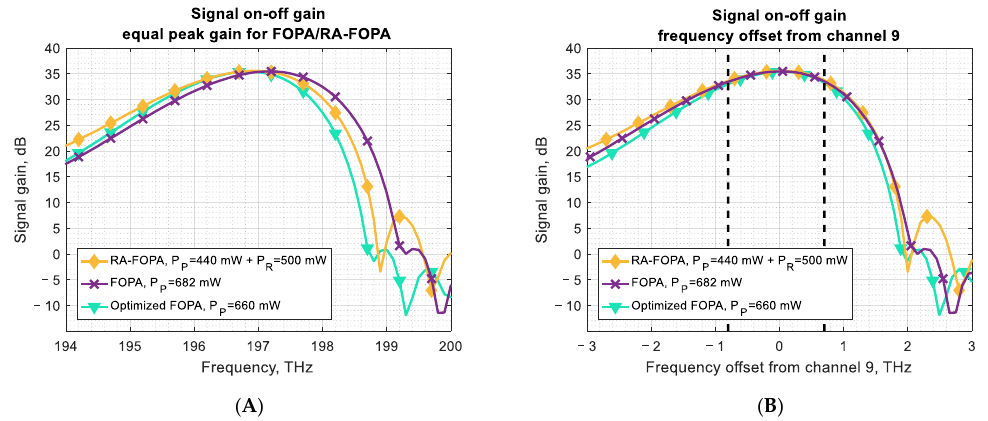
Figure 3. Fiber optical parametric amplifiers (FOPA) (violet line, crosses), optimized FOPA (cyan line, triangles) and RA- FOPA (yellow line, diamonds) signal on-off gain curves with the horizontal axis set to the ( A ) frequency band from 194 up to 200 THz (1498.96 – 1545.32 nm); ( B ) frequency offset from channel 9 with two vertical black dashed lines representing the frequency band in which all 16 WDM channels are located.